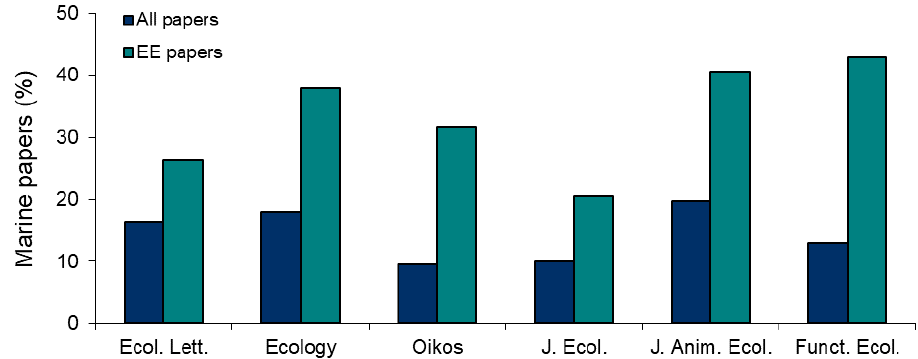
Figure 1. Marine studies as the percentage of all papers published in six general ecological journals (All papers) and as the percentage of all the ecosystem engineering papers published in these same journals (EE papers). The analysis considered studies published from 1994 (i.e., when the foundational paper on the ecosystem engineering concept was published; see [1]) to 2019. EE papers were defined as those including the terms “ecosystem engineer” or “ecosystem engineering” in their title and/or abstract. Marine papers were defined as those including any of the following words in